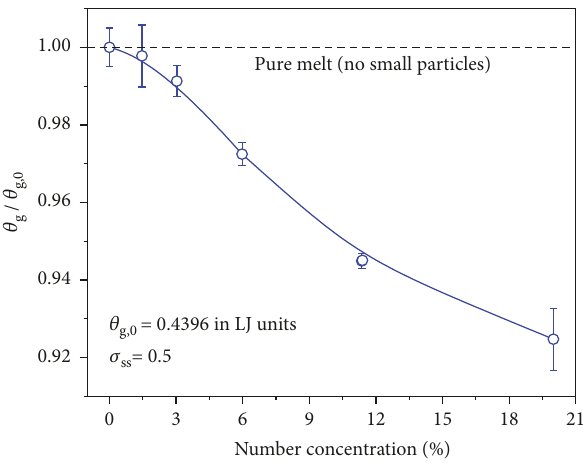
Figure 9: Results of MD simulations on θ versus the concentration g of small molecules, which di ff use into a polymer melt. The polymer melt is modelled here as a coarse-grained linear chain. The small molecules are spherical Lennard-Jones (LJ) particles. Despite the generic feature of the model, the qualitative trend observed here is in agreement with experiments [41]. Results from calculations performed on three independent packing